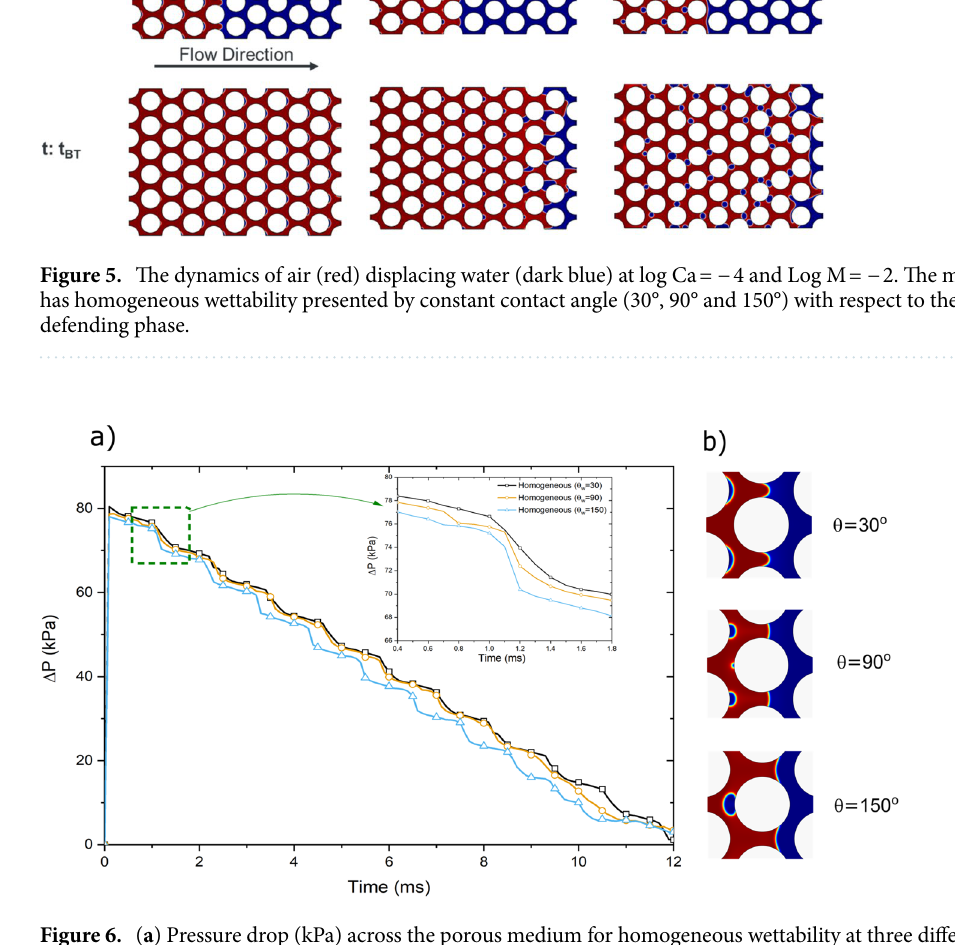
Figure 6. ( a ) Pressure drop (kPa) across the porous medium for homogeneous wettability at three different contact angles (30°, 90° and 150°) during displacement at log Ca = − 4 and log M = − 2. ( b ) The corresponding pore filling and trapping events of stepwise pressure drops (one is shown the dotted green